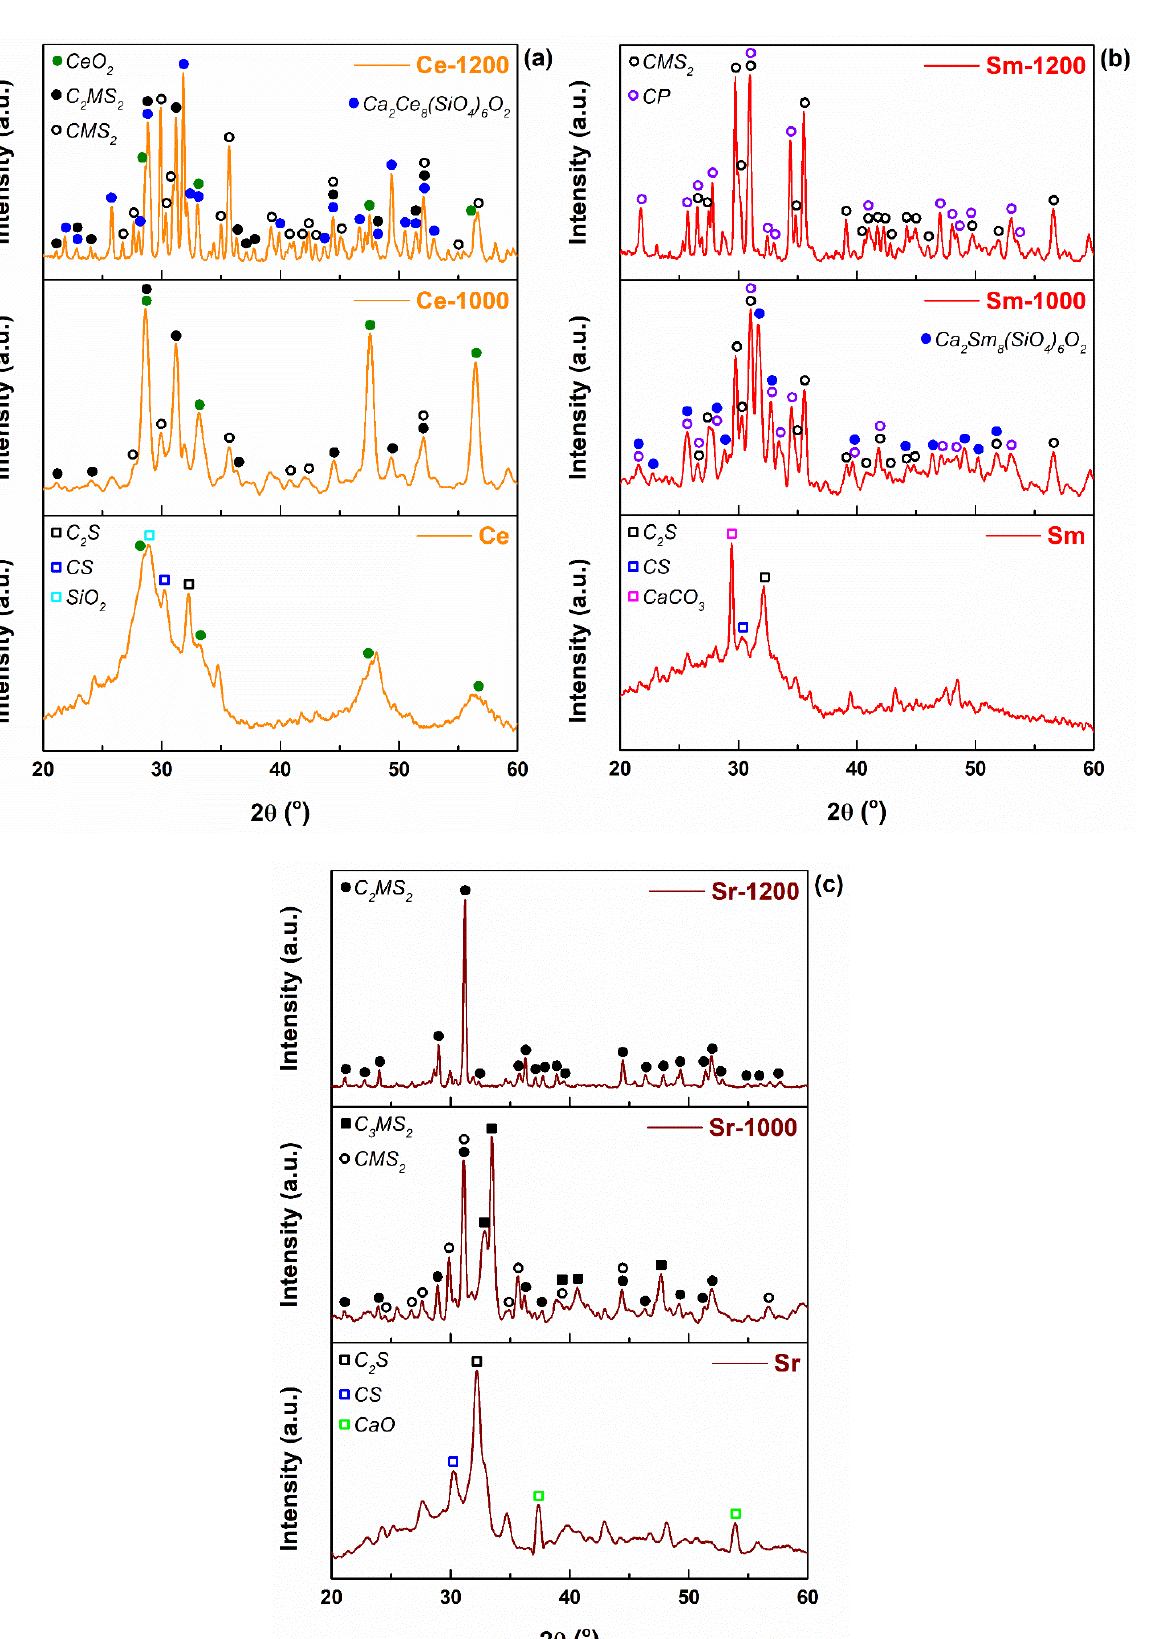
Figure 7. XRD patterns of the developed materials: ( a ) Ce-containing composition, ( b ) Sm-containing composition and ( c ) Sr-containing composition.